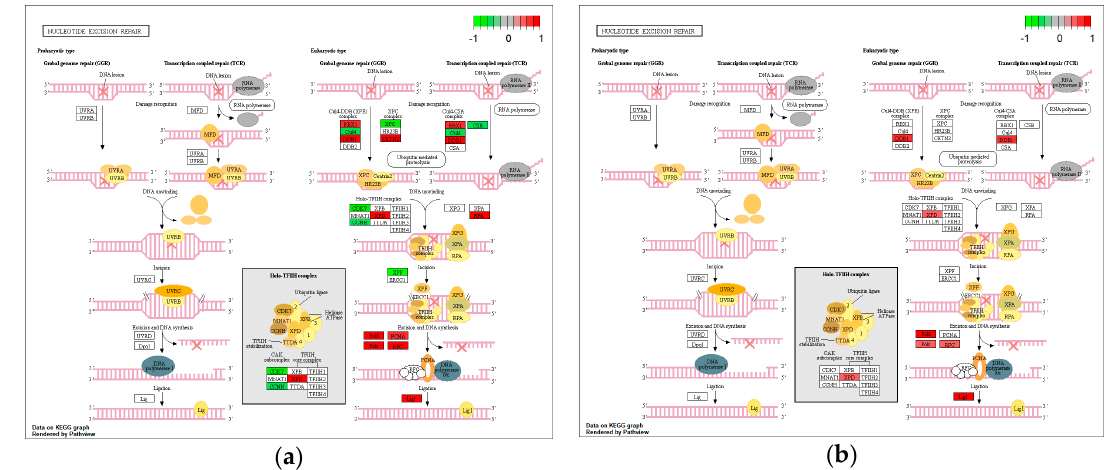
Figure 3. Impact of H. pylori infection ( a ) and CagA protein ( b ) on gene expression of nucleotide